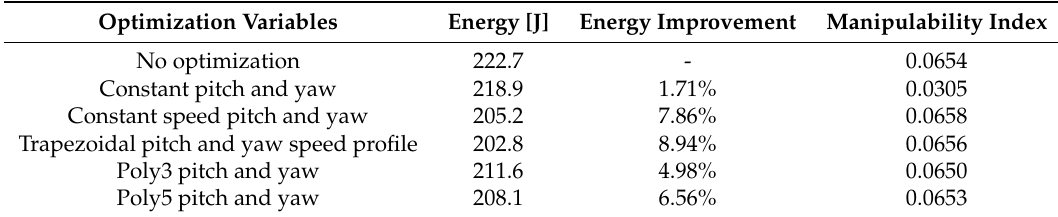
Table 7. Energy minimization: test-case II, motion along a vertical